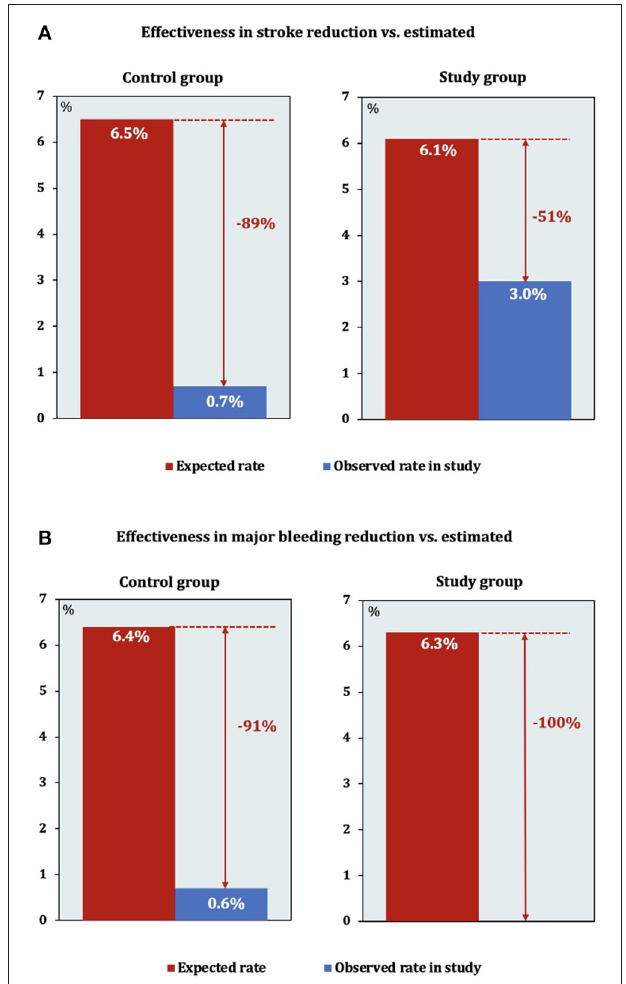
FIGURE 3 | Effectiveness of left atrial appendage closure (LAAC) in reducing stroke and bleeding based on the annual rate predicted by the CHA 2 DS 2 -VASc score and HAS-BLED score in the control group (A) and study group (B) . Both periprocedural and follow-up events were included in the